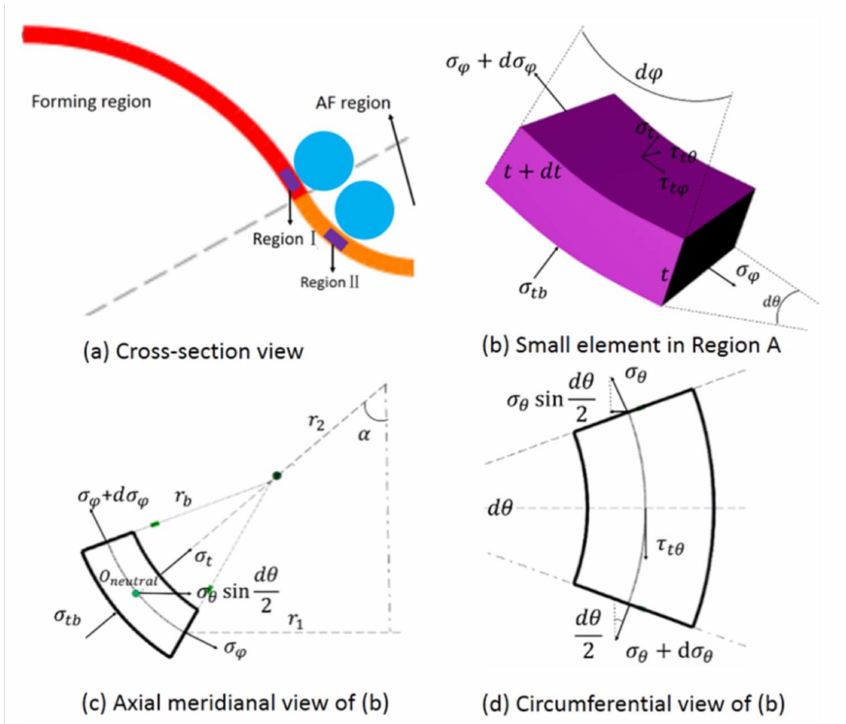
Figure 3. Schematic representation of the target sheet in CBS: ( a ) Cross-section view; ( b ) Small element in Region A; ( c ) Axial meridianal view of ( b ); ( d ) Circumferential view of ( b